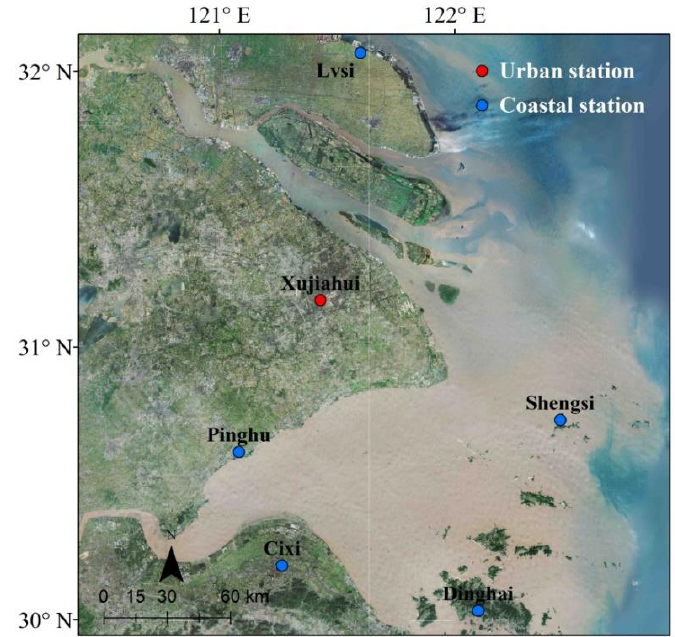
Figure 4. Locations of Xujiahui and five coastal stations.